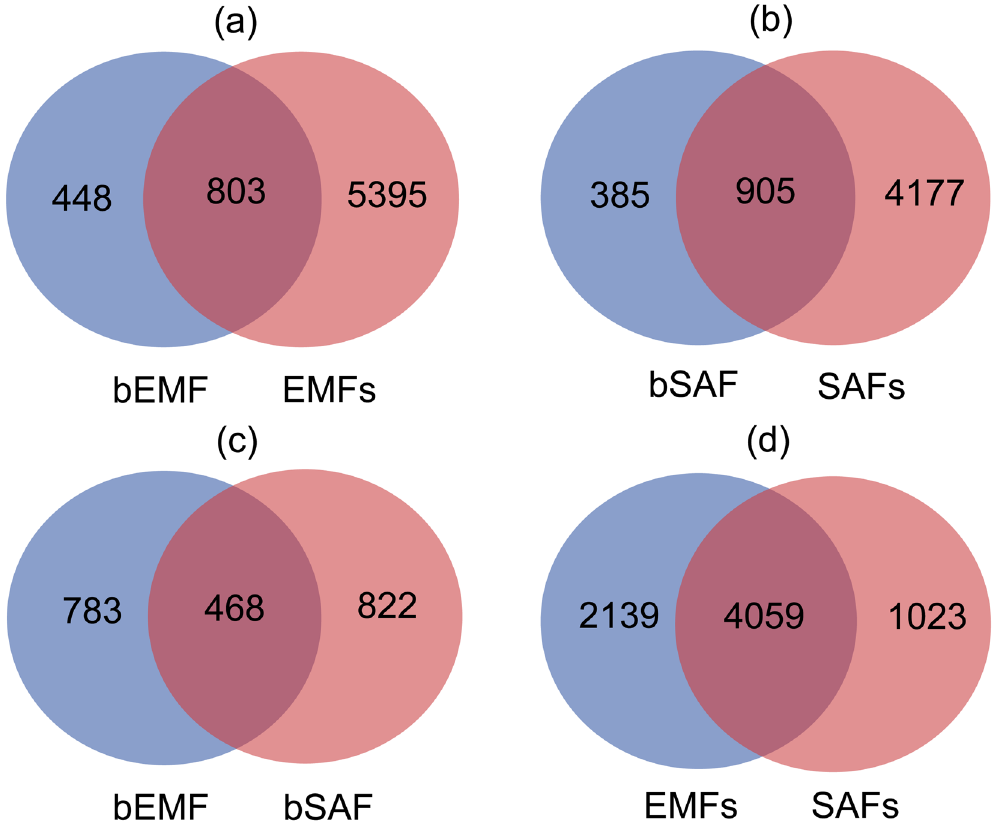
Figure 6. Venn diagram analysis for unique and shared OTUs among all the analyzed samples. ( a ) Comparison between bEMF and EMFs; ( b ) Comparison between bSAF and SAFs; ( c ) Comparison between bEMF and bSAF; ( d ) Comparison between EMFs and